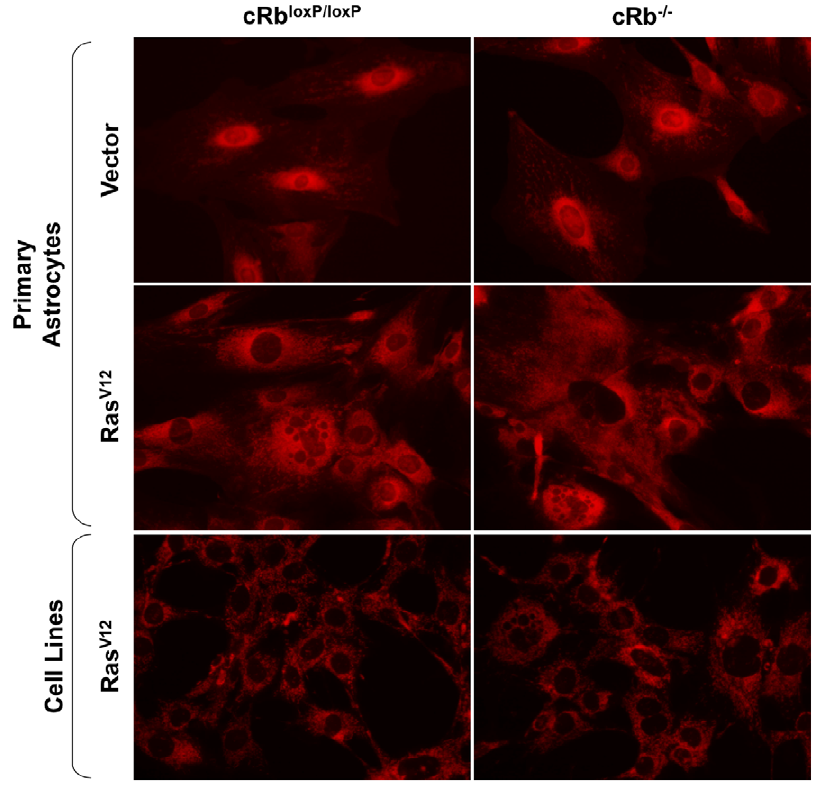
Figure 4. Mitochondrial changes in astrocytes. MitoTracker Red CMXRos fluorescence images of primary astrocytes 6 days after selection and astrocyte lines T653 and T731. Oncogenic ras expression induced distribution of the mitochondria throughout the cell cytoplasm, whereas control cells (Rb loxP/loxP and cRb 2 / 2 ) showed a concentration of mitochondria around the nuclei of cells.